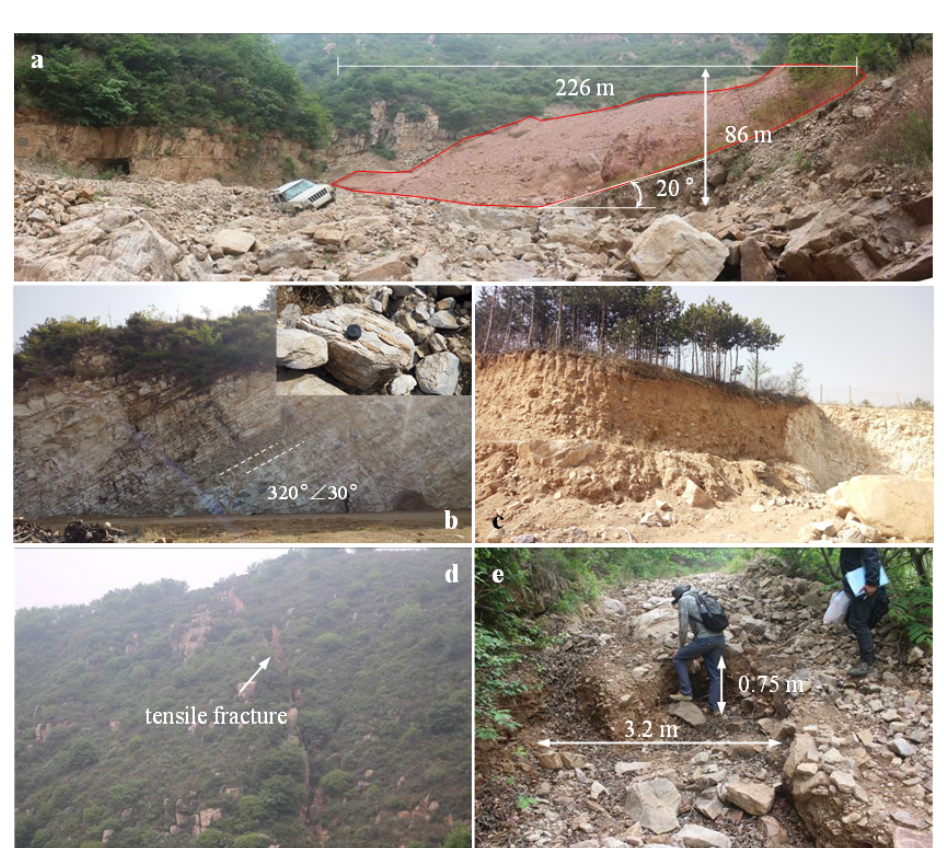
Figure 3. Field investigation photos. (a) Loose material, (b) Middle and Late Proterozoic dolomite, (c) colluvium deposit, (d) slope fracture and (e) channel erosion